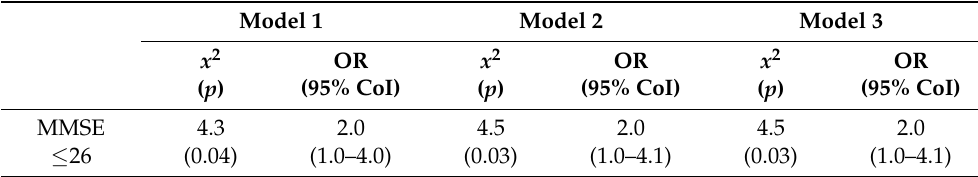
Table 10. Odds of MMSE scores indicative of MCI by KCNJ2 -A allele presence in the total cohort, in models adjusting for diet quality.